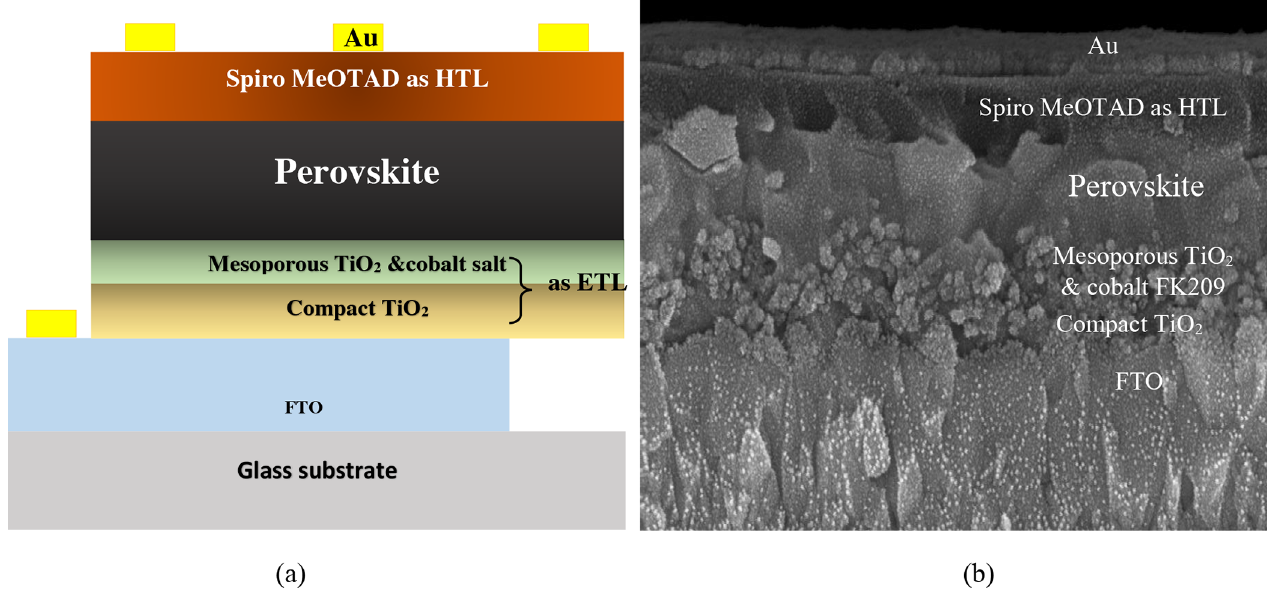
Fig. 4. (a) Schematic structure of the fabricated PvSC (2-D), and (b) an SEM image of the cross section of the device fabricated in this